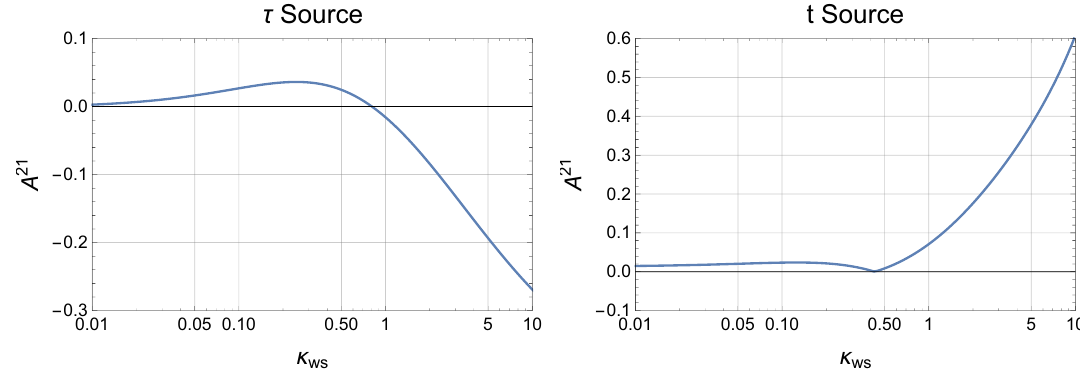
Figure 9. The relative difference A 21 between the one- and two-step approaches as a function of the weak sphaleron rate. As Γ ws is lowered, A 21